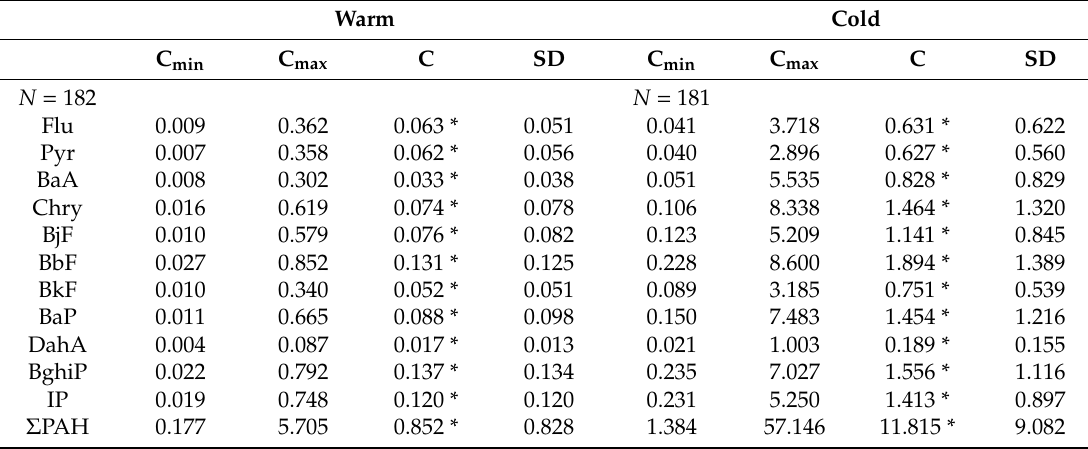
Table 1. Average, minimum, and maximum values and standard deviations of the PAH 24-h mass concentrations during the cold and warm period (ng m − 3 ).